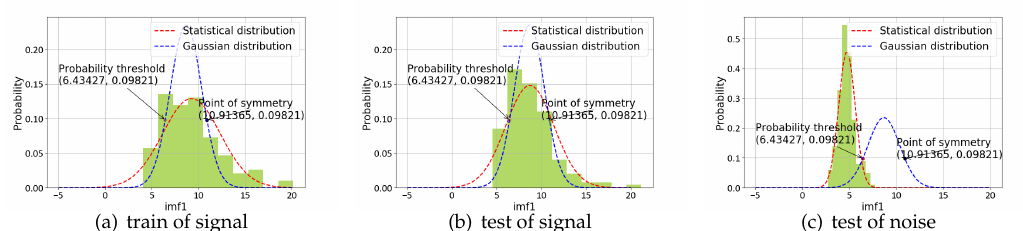
Figure 9. The probability distribution of the energy value of the signal IMF1 component of EMD. From ( a ) to ( c ), the subgraphs are the train set data distribution, the seismic test set distribution, and the noise test set distribution of the energy. The red dotted line represents the statistical distribution, while the blue dotted line is distribution obtained by the Gaussian process using prior